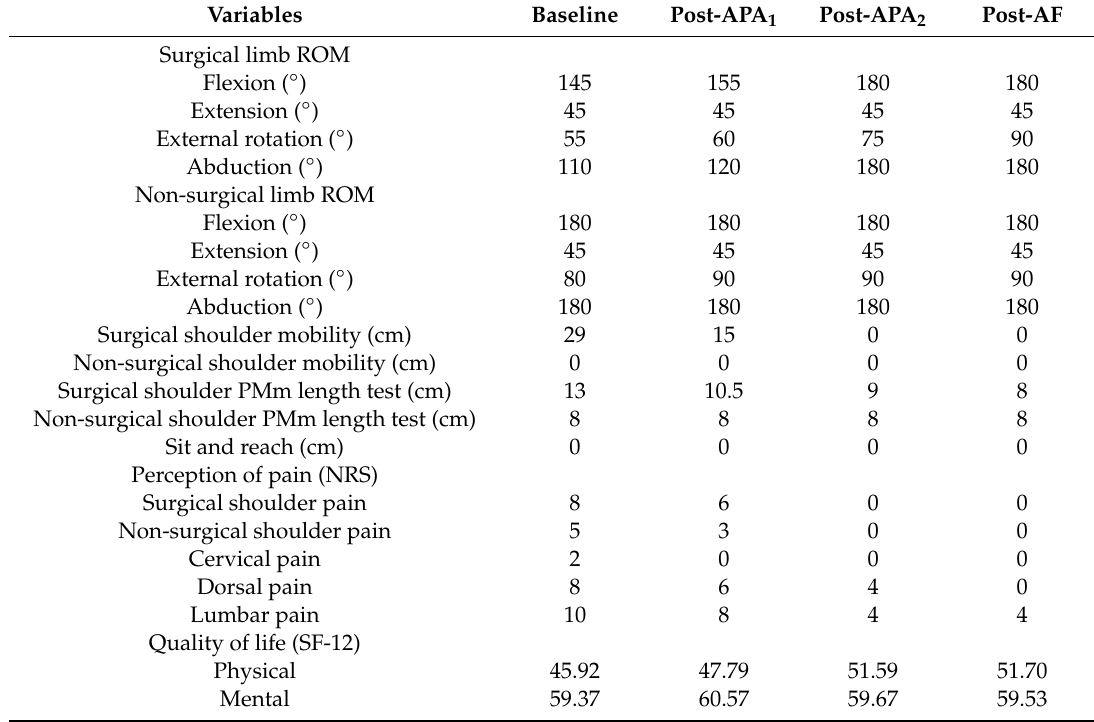
Table 1. Fitness tests, pain intensity and quality of life scores at baseline and after the end of either two adapted physical activity (APA 1 and APA 2 ) or adapted fitness (AF)